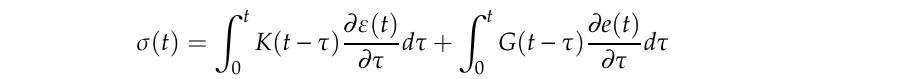
Figure 6. Growth of contact area with viscoelastic relaxation.